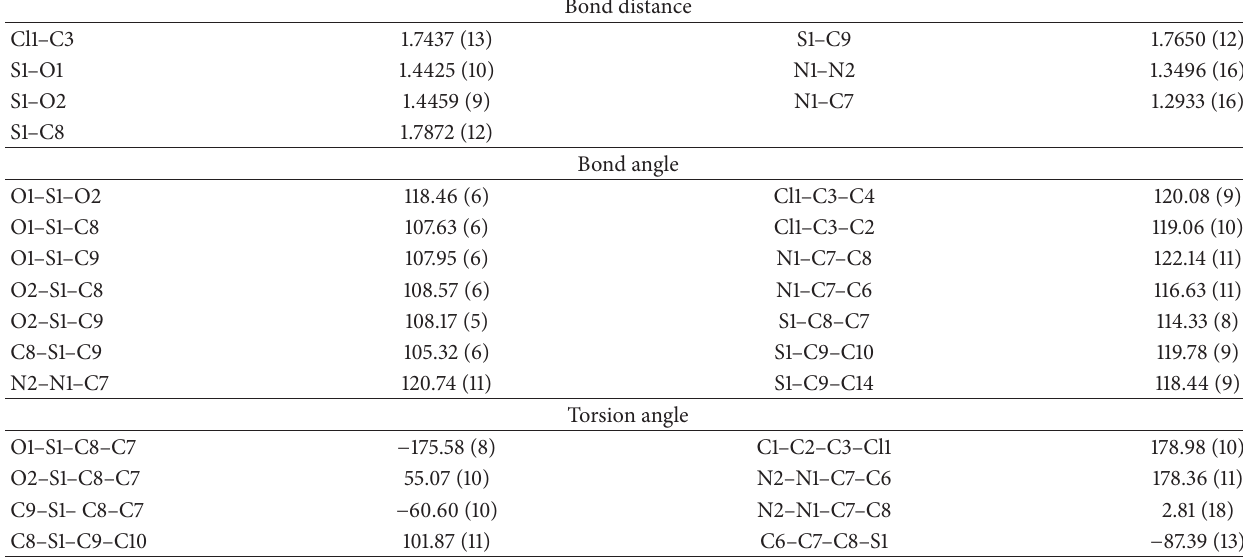
Table 1: Selected geometric parameters (˚A, ∘ ) of 5a .